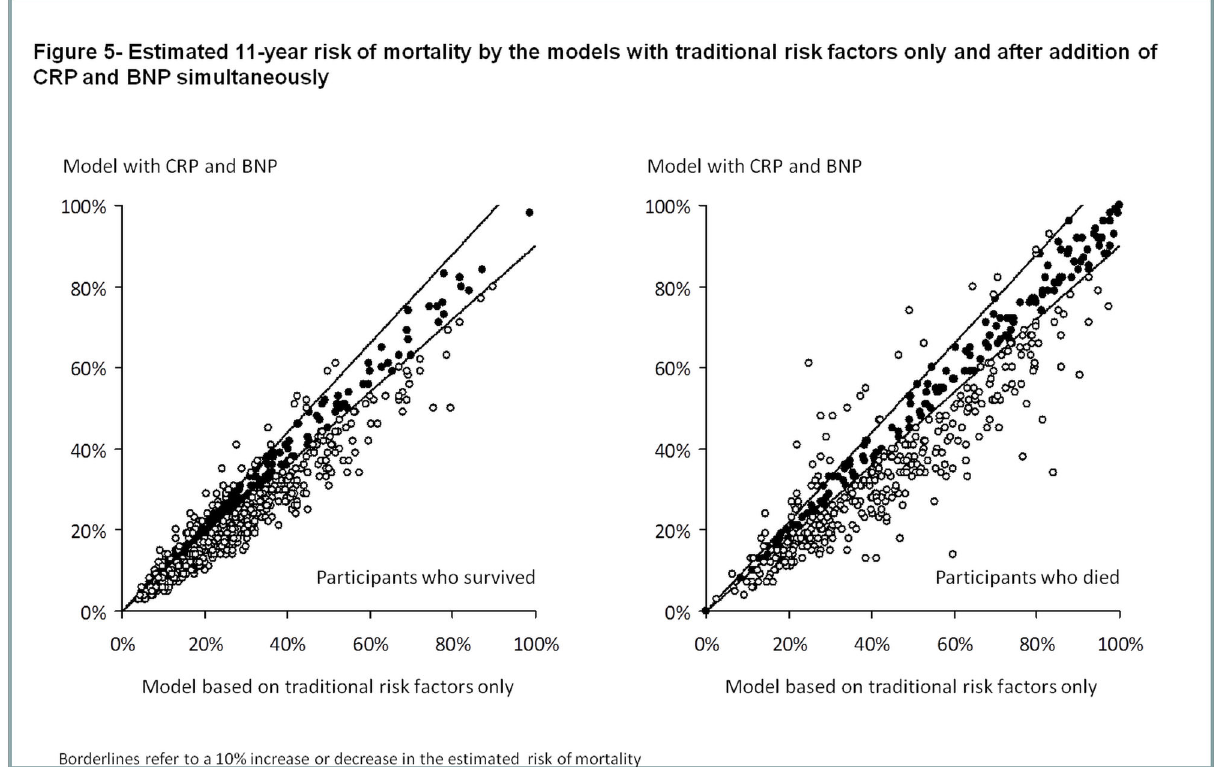
Figure 5. Estimated 11-year risk of mortality by the models with traditional risk factors only and after addition of CRP and BNP